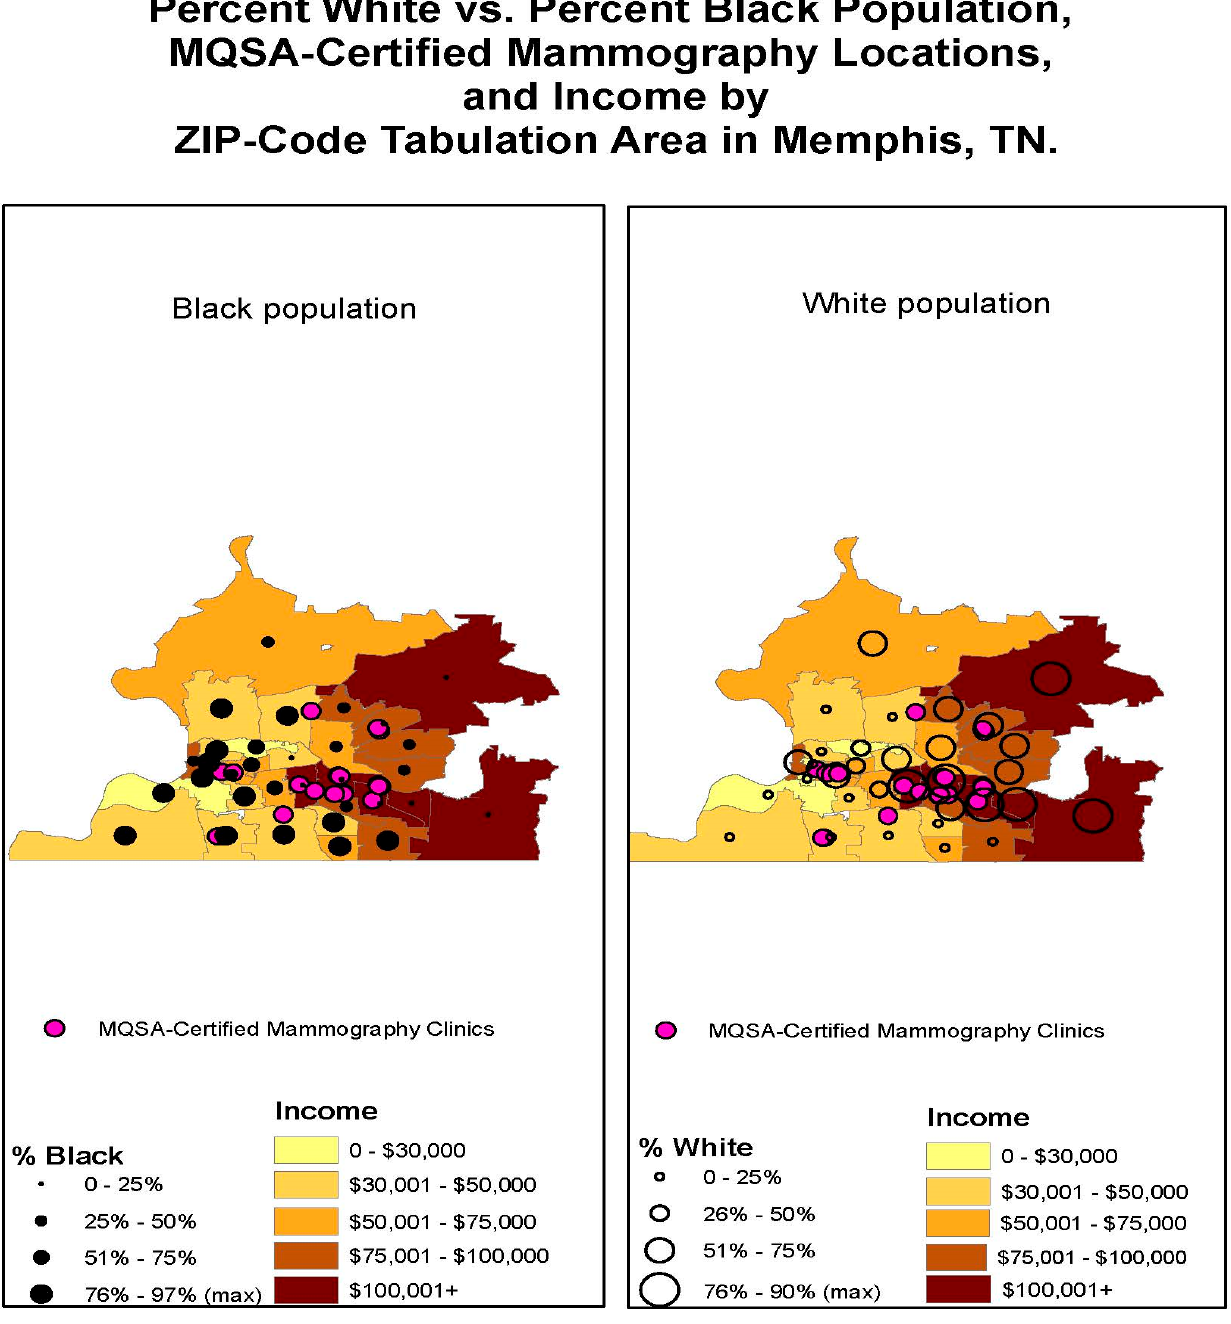
Figure A5. Percent White vs. Percent Black Population, MQSA-Certified Mammography Locations, and Income by ZIP-Code Tabulation Area in Memphis, TN.